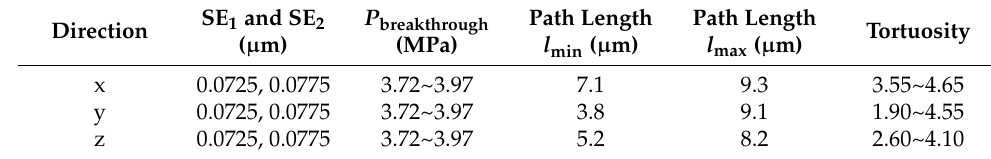
Table 4. Numerical calculation results for the COx argillite.